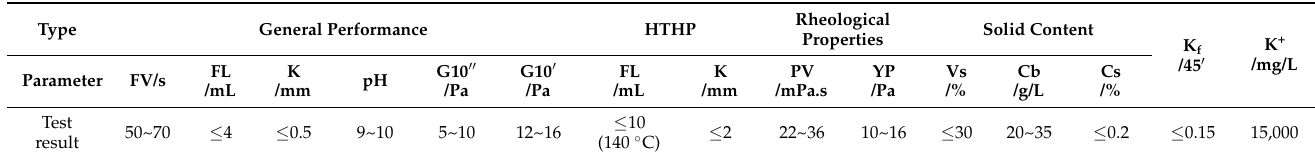
Table 7. Optimized performance parameters of the modified starch polyamine anti-collapse water- based drilling fluid tested on